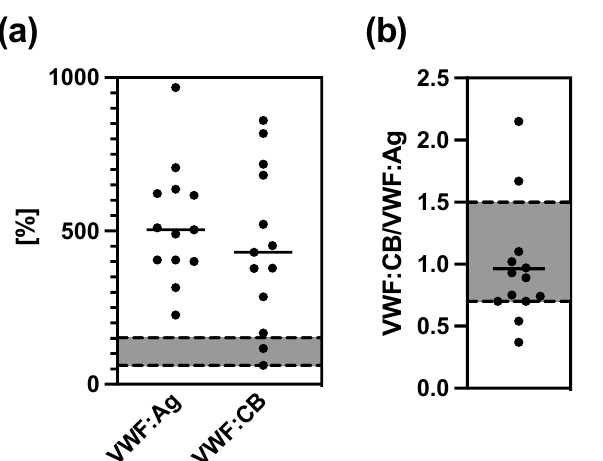
Figure 3. VWF:Ag and VWF:CB ( a ), and VWF:CB/VWF:Ag ratio ( b ) in COVID-19 patients ( n = 13). Gray area marks normal range.